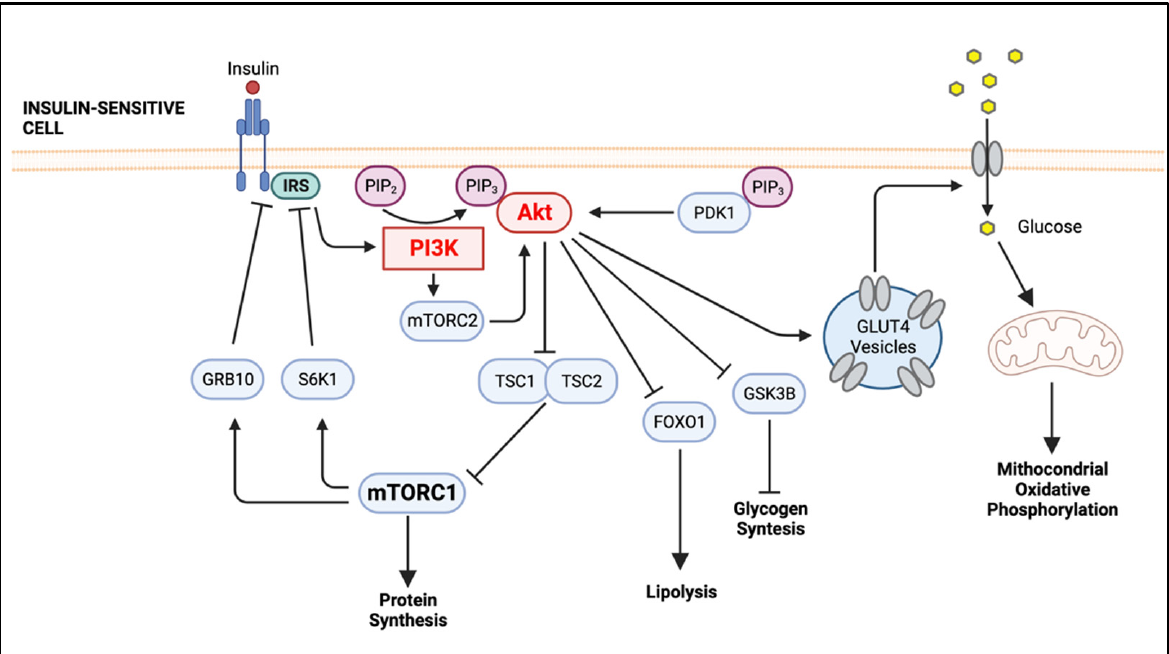
Figure 1. Insulin Signaling in Insulin-responsive Cell. In healthy individuals, insulin binds to the ectodomain of IRs, causing a conformational change that leads to the autophosphorylation of the tyrosine residues in the cytoplasmic β subunits. The IRS then binds to the phosphorylated tyrosine residues of IRs, causing them to be phosphorylated. Phosphorylated IRSs bind to PI3K, and as a consequence, PI3K is activated and converts PIP2 to PIP3. PIP3 recruits the serine/threonine kinase Akt (also known as protein kinase B) to the plasma membrane, where it is activated by phosphorylation. The activated Akt is responsible for the translocation of GLUT4 to the plasma membrane, allowing the entry of glucose into the cell, which will be used to produce ATP through mitochondrial oxidative phosphorylation. Activated Akt also promotes the inhibition of GSK3B, which leads to higher glycogen synthesis. Once activated, Akt also inhibits transcription factor FOXO1, which promotes transcription of lipoprotein lipase, an enzyme responsible for the breakdown of triglycerides. Furthermore, phosphorylated Akt inhibits TSC1/2, and as a consequence, mTORC1 is activated, which leads to protein synthesis. Activation of S6K1 by mTORC1 phosphorylates inhibitory serine residues on the IRS, while mTORC1-induced activation of GRB10 prevents insulin signaling by binding to IR. (Created with BioRender.com on 19 October 2022). Abbreviations: IRs, insulin receptors; IRS, Insulin receptor substrate; PI3K, phosphoinositide 3-kinase; PDK1, 3-phosphoinositide-dependent protein kinase 1; PIP 2 , phosphatidylinositol 4,5-biphosphate; PIP 3 , phosphatidylinositol 3,4,5-trisphosphate; GLUT4, glucose transporter type 4; GSK3B, glycogen synthase kinase 3 β ; FOXO1, forkhead box O; TSC1/2, tuberous sclerosis protein complex 1 and 2; mTORC1, mammalian target of rapamycin complex 1; mTORC2, mammalian target of rapamycin complex 2; S6K1, S6 kinase 1; GRB10, growth-factor-receptor-bound protein 10. The insulin receptor (IR) is a disulfide-linked homodimer that belongs to the receptor